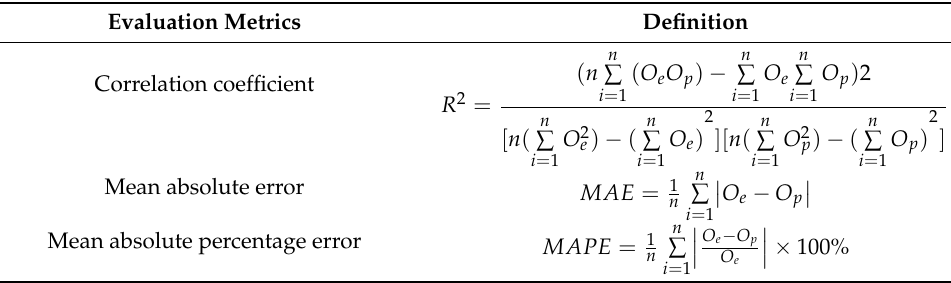
Table 2. Definitions of evaluation